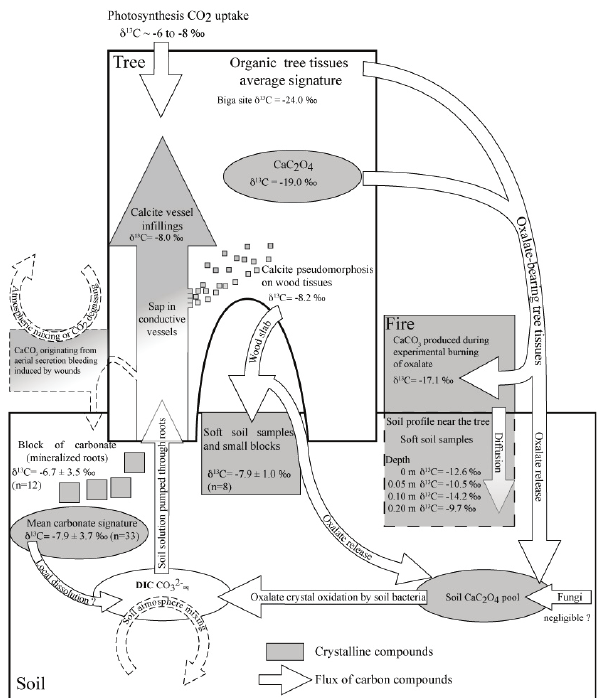
Fig. 7. Sketch of an iroko ecosystem at the Biga site (Ivory Coast) showing the various carbon fluxes and their associated mineral and organic compounds illustrated by the distribution of isotope carbon signatures. The multiple relationships between pools and agents are defined based on multiscalar observations (from field to lab). δ 13 C signature from atmospheric CO 2 is given as an illustration; no measurement was